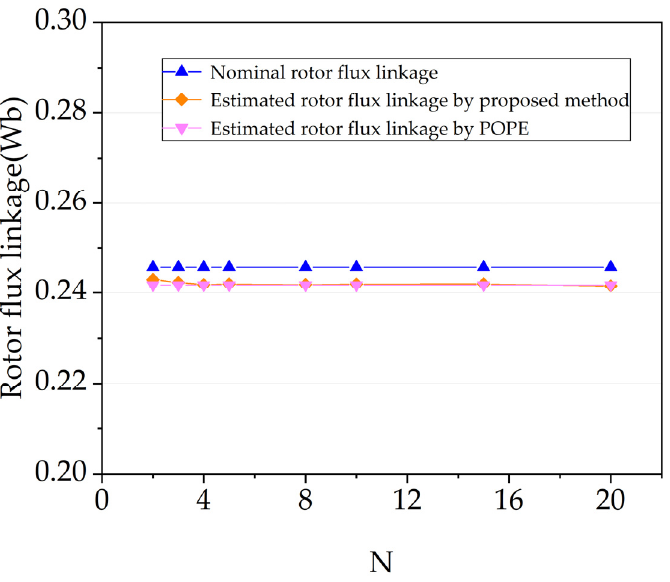
Figure 7. Nominal and estimated rotor flux linkage of the proposed and POPE method at different values of N .